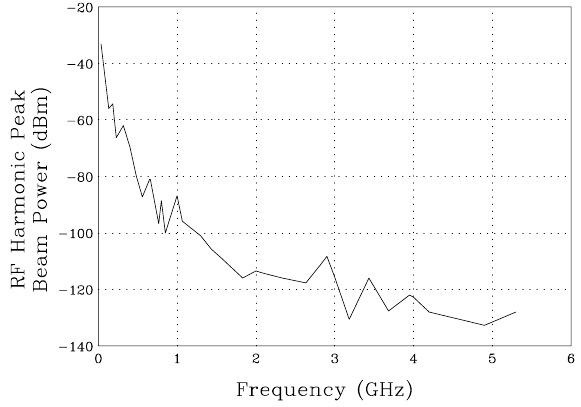
FIG. 7. The beam current power spectrum of the Tevatron, measured at each harmonic of the rf frequency. decay, muon cooling, rf rotations, and muon